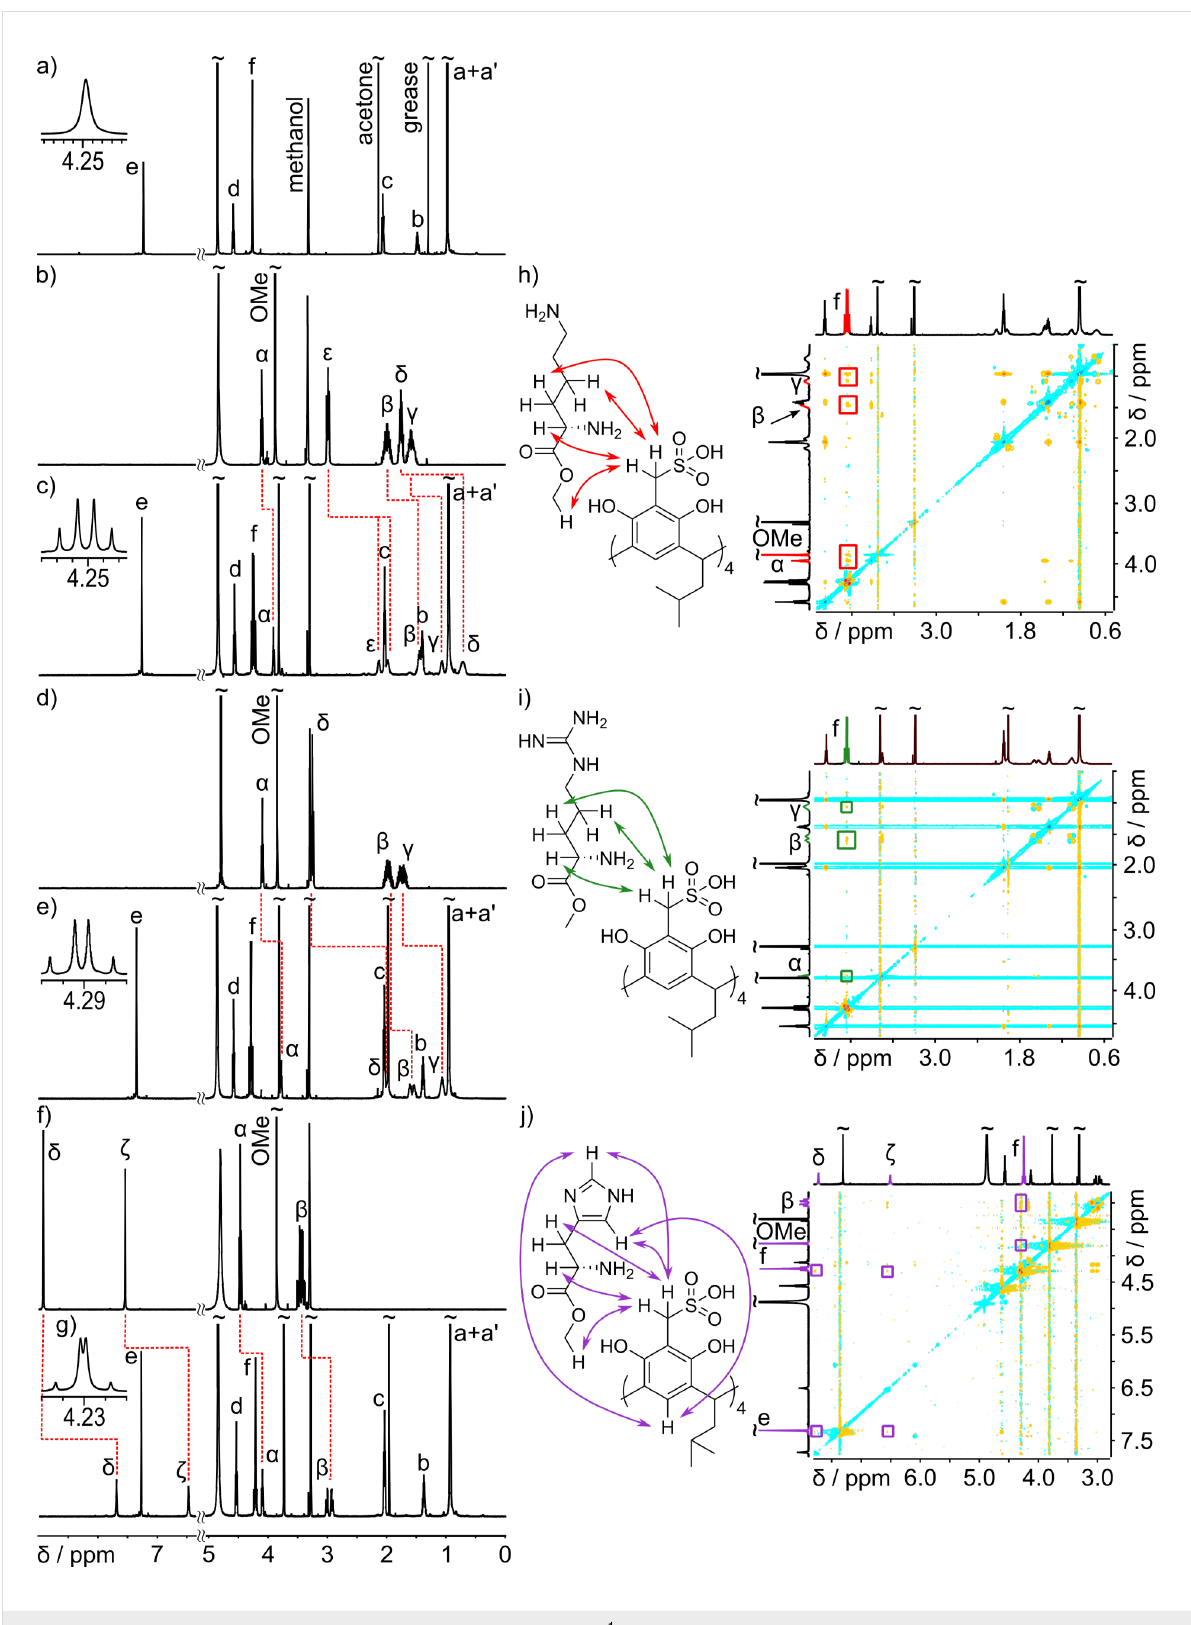
Figure 2: Spectra of complexes [ 1 (LysOMe) 2 ], [ 1 (ArgOMe) 2 ], [ 1 (HisOMe) 2 ]: 1 H NMR (a–g) and ROESY (h–j) in methanol at 298 K, 600 MHz